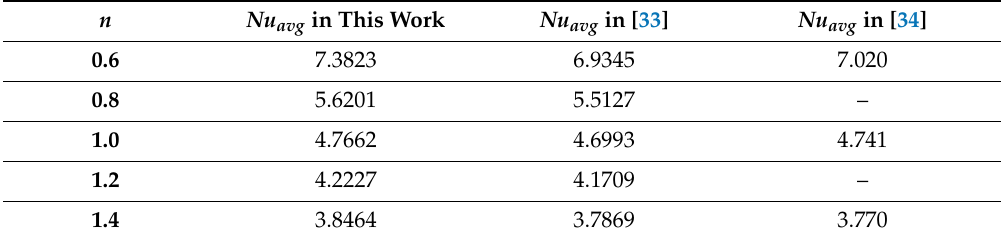
Figure 3. Streamlines: Data from [33] ( a ) and obtained results ( b ). Table 1. The value of the average Nusselt number depending on the power law index.